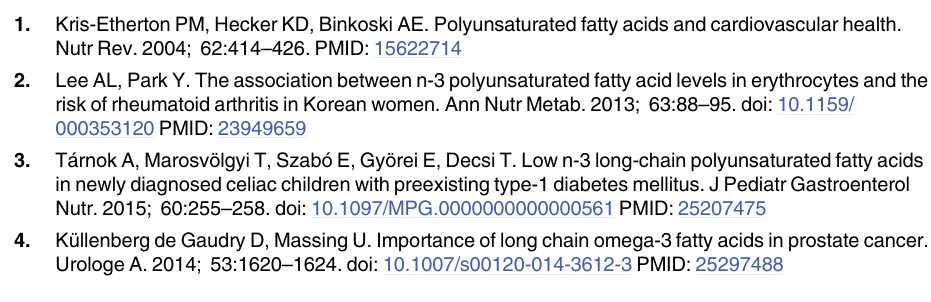
S1 Fig. Microarray cellular component (GO Ontology) classification. The x-axis indicates the likelihood [ − log2(pvalue)] in a category, and the y-axis indicates the different subcategories of cellular components. S2 Fig. Microarray molecular function (GO Ontology) classification. The x-axis indicates the likelihood [ − log2(pvalue)] in a category, and the y-axis means the different subcategories of molecular function. S1 Table. Primers used in the relative quantification of the selected genes from the microar- ray data. S2 Table. Discrepancy of the expression and up regulation of transcripts in the fat-1 trans- genic cattle. S3 Table. Discrepancy of the expression and down regulation of transcripts in the fat-1 transgenic cattle. S4 Table. The information regarding the significantly enriched genes in each GO term related to lipid metabolism. S5 Table. The significantly enriched genes in the ‘ PPAR signaling pathway ’